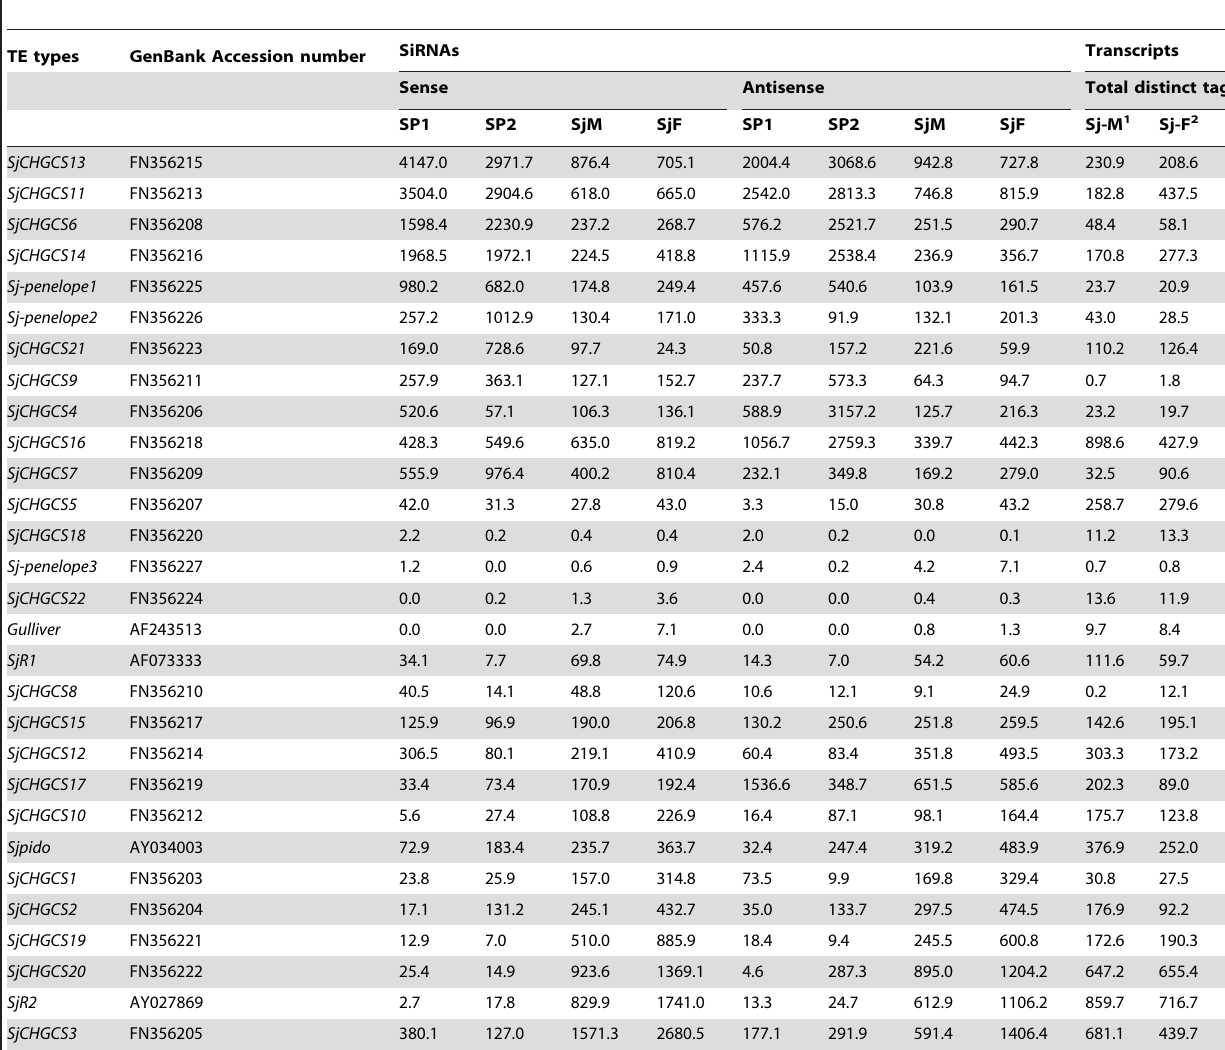
Table 2. Transcriptional levels (TPM) of 29 types of well-defined retrotransposons and the corresponding siRNAs in different libraries from adult worms of S. japonicum